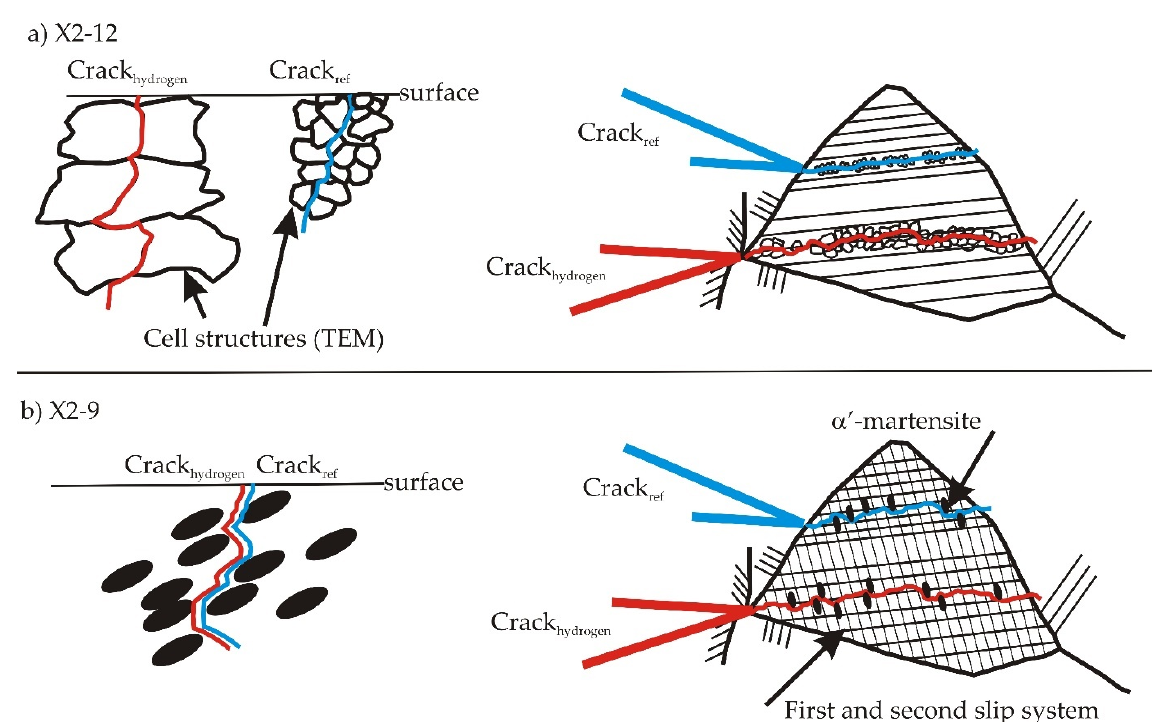
Figure 11. Schematic representation of the formation of different dislocation cell structures and crack propagation paths in reference specimens (red) and hydrogen precharged samples (blue) of ( a ) X2-12 and ( b ) X2-9.